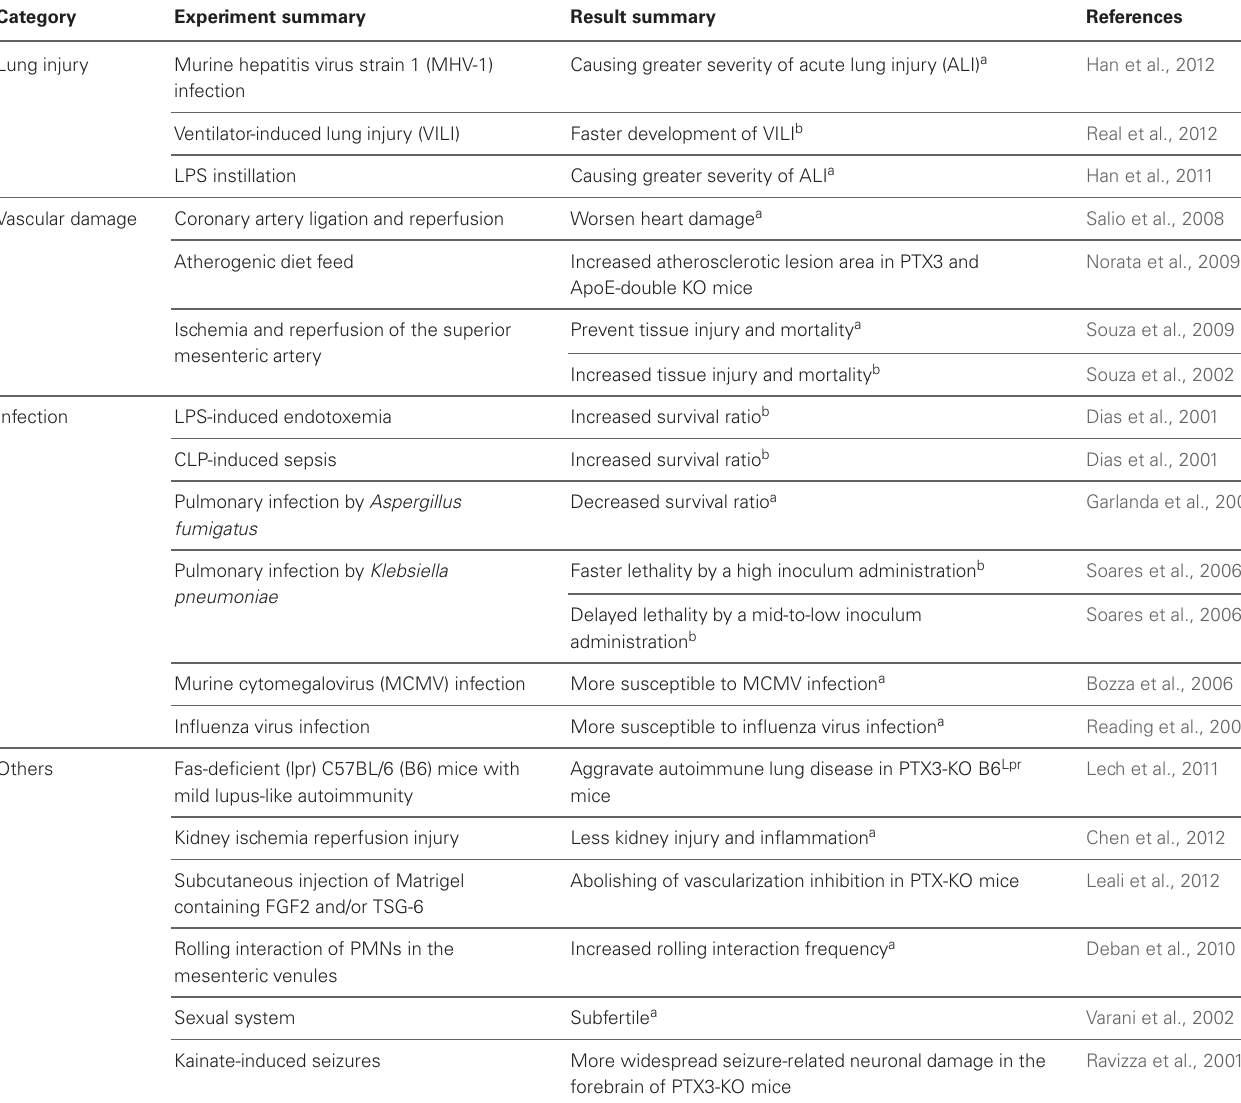
Table 2 | Responses to certain disorders in PTX3-knockout and PTX3-transgenic